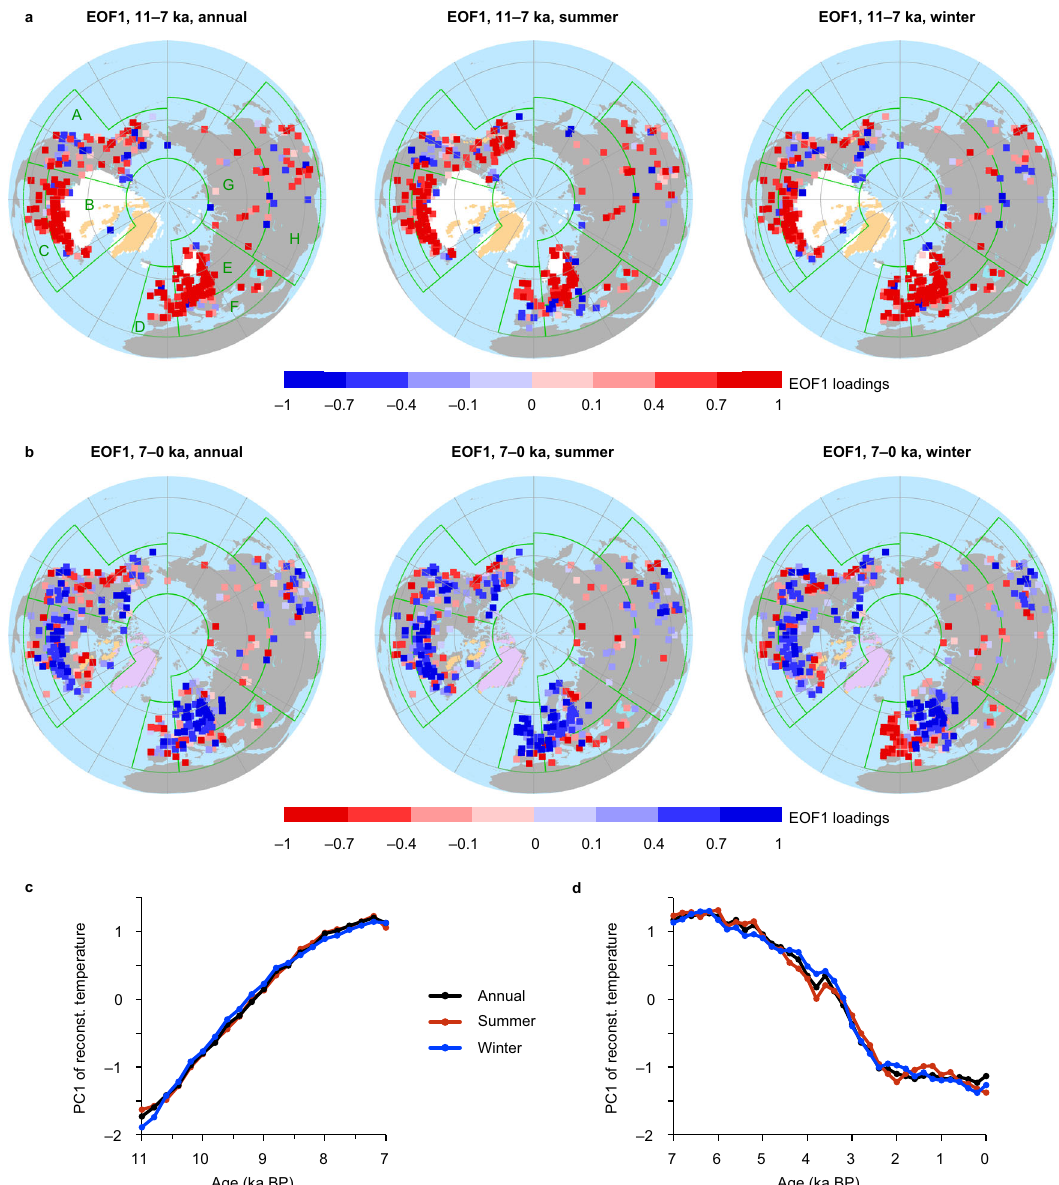
Fig. 2 | Spatial patterns of Holocene temperature variations revealed by empiricalorthogonalfunction(EOF)analysis.a EOF1patternsofannual,summer and winter temperatures from 11 to 7 kaBP. b As( a ) but forperiod from 7 kaBPto present. The maps show the correlation coef fi cient between the reconstructed series and PC1 ( c and d ) instead of the actual EOF1 values. The percentages of the total variance explained by PC1 are 58%, 52% and 58% for annual, summer and winter temperatures, respectively, during 11 – 7 ka BP, and 36%, 31% and 42%, respectively, during 7 – 0 ka BP. The white, yellow and pink shading indicates the